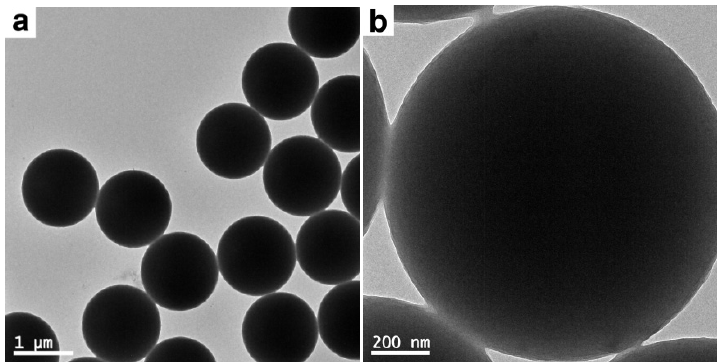
Figure 2. TEM images of PVP-stabilized PS particles at ( a ) lower and ( b ) higher magnifications.